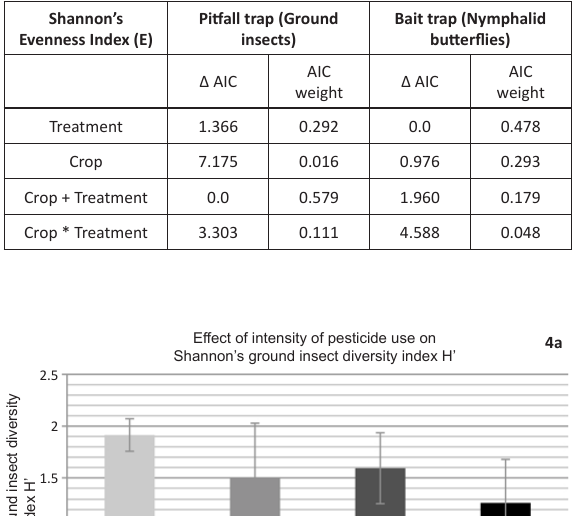
Figure 5a. Bar plot for ant species shows the mean Shannon’s diversity index H’ for all treatments with their 95% confidence intervals (CI); Figure 5b. Bar plot for ant species shows mean Shannon’s evenness index E for all treatments with their 95% confidence intervals (CI). Note the 95% CI of treatments organic (G) and NPK + pesticide (P) do not overlap in either plot.